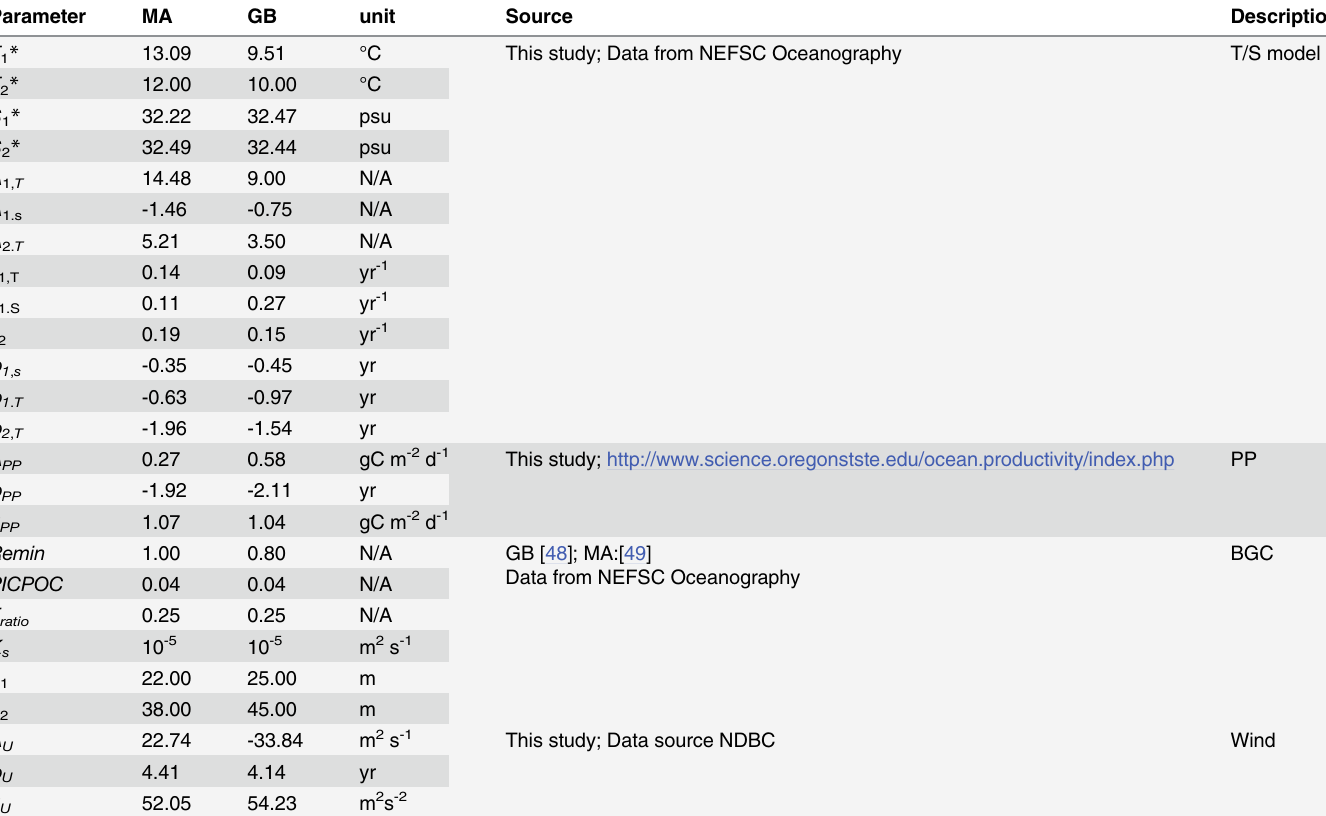
Table 1. Parameters from BGC model.